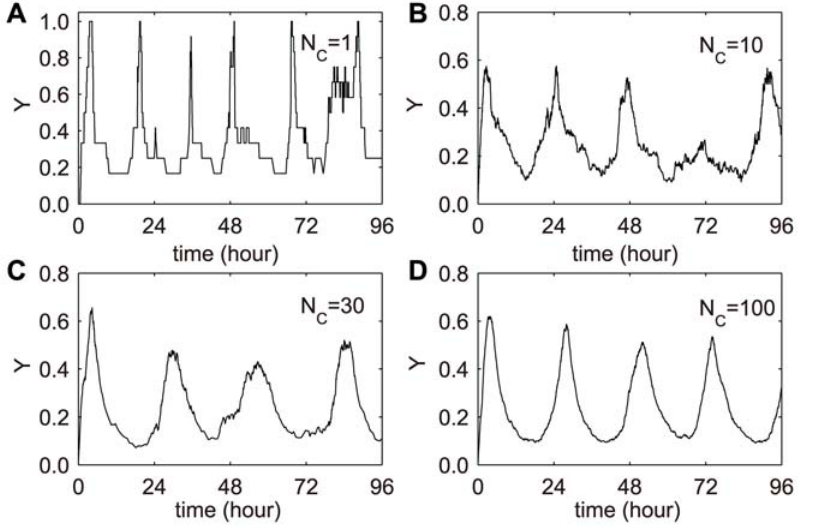
Figure 3. Circadian KaiC phosphorylation at low protein numbers. The ratio of the amounts of Kai proteins are fixed by N A : N B : N C < 1 : 3 : 1, where N A , N B and N C stand for the total numbers of KaiA dimers, KaiB dimers and KaiC hexamers, respectively. The ratio of total Kai protein numbers to the cell volume is set to be constant. KaiC phosphorylation cycle can be generated as N C =1 (A), N C =10 (B), N C =30 (C) and N C =100